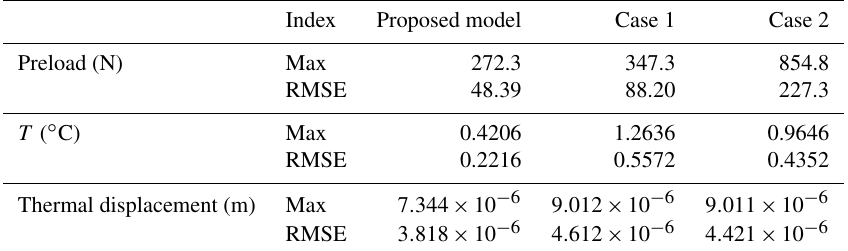
Figure 10. Relationship between axial displacement and axial force. (a) Without considering thermal effects. (b) Considering thermal effects. Table 2. Prediction accuracy of the models. Index Proposed model Case